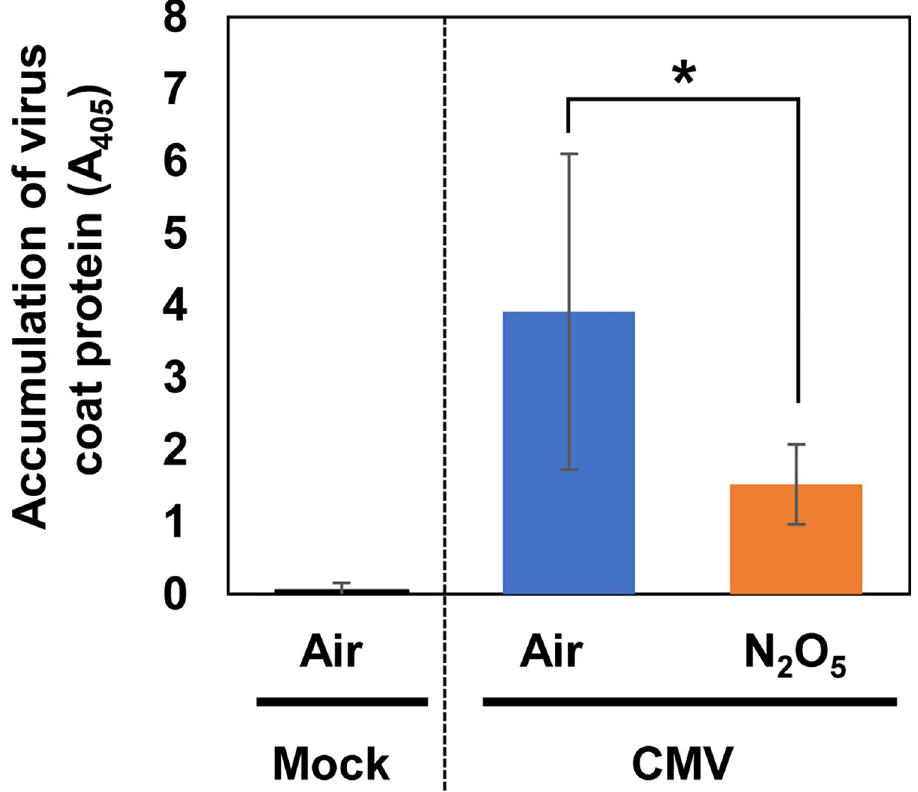
Fig 4. Induction of cucumber mosaic virus resistance in Arabidopsis plants by N 2 O 5 gas exposure. Arabidopsis plants exposed to N 2 O 5 gas were inoculated with CMV(Y). Two days after inoculation, the inoculated leaves were harvested and subjected to enzyme-linked immunosorbent assay using an antibody against the CMV CP. Asterisks denote significant differences (Student’s t -test, n = 6, P <